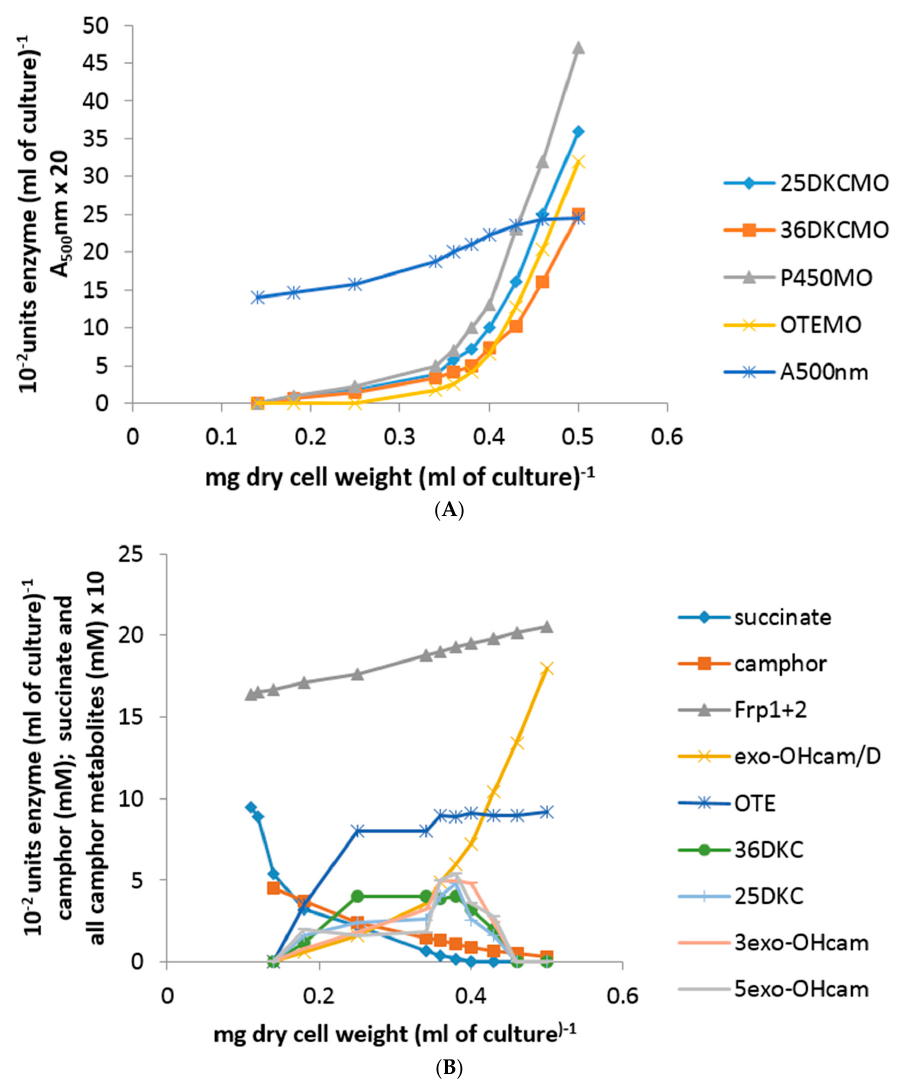
Figure 2. ( A , B ) Changes in the optical density (A 500 nm) of P. putida NCIMB 10007 following addition of ( rac )-camphor as inducer-substrate to succinate minimal medium and concomitant changes in the activity of key enzymes and metabolic intermediates of the camphor degradation pathway.